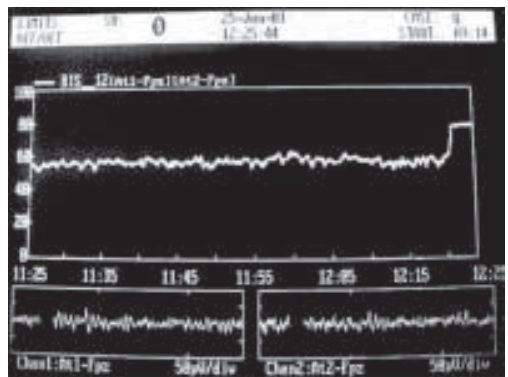
Fig. 4 - BIS (Bispectral Index).